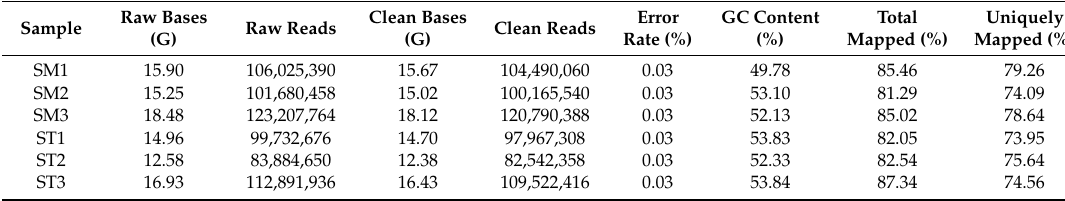
Table 2. The information of RNA-seq result data.